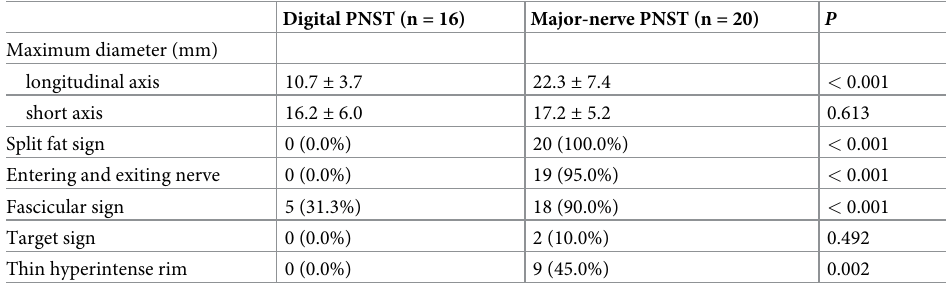
Table 2. Comparison of MRI findings between digital PNST and major-nerve PNST.